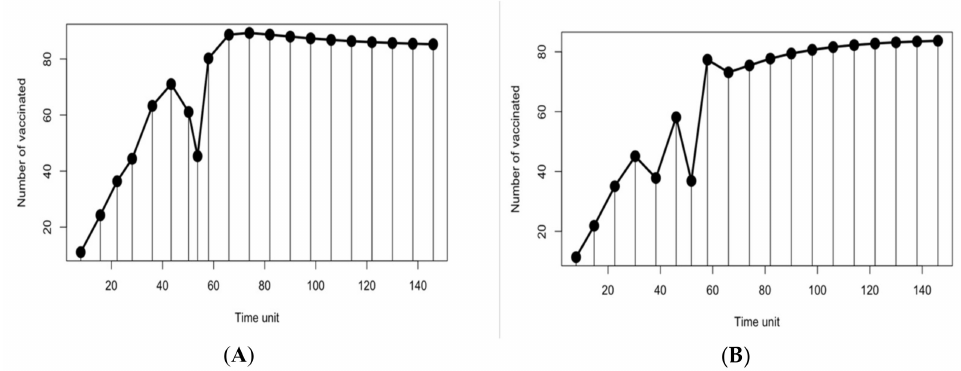
Figure 12. Mean number of vaccinations for ( A ) solution 8 from the NSGA-II non-dominated set and ( B ) solution 10 from the CENSGA non-dominated set.